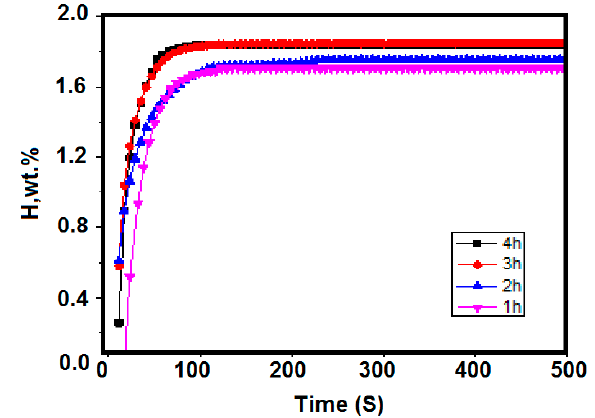
Figure 4. Hydrogen absorption kinetics curves at different activation times of 400 °C at 0.1 MPa.